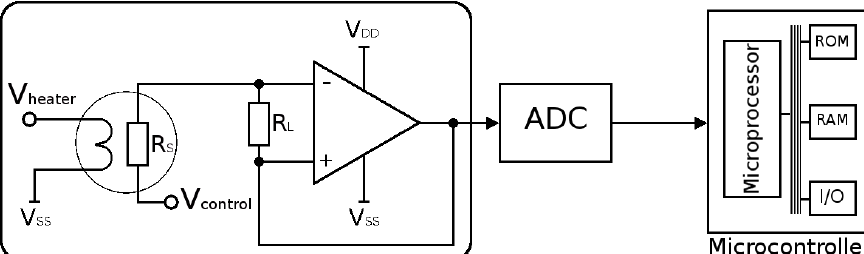
Figure 2. Schematic of an SMO sensor with interface blocks. The sensor includes a heating element and sensing film, a voltage follower, and an analog-to-digital converter (ADC). To process the sensor data, it is connected to a microcontroller, which contains a read-only-memory (ROM), random access memory(RAM), and input/output (I/O)